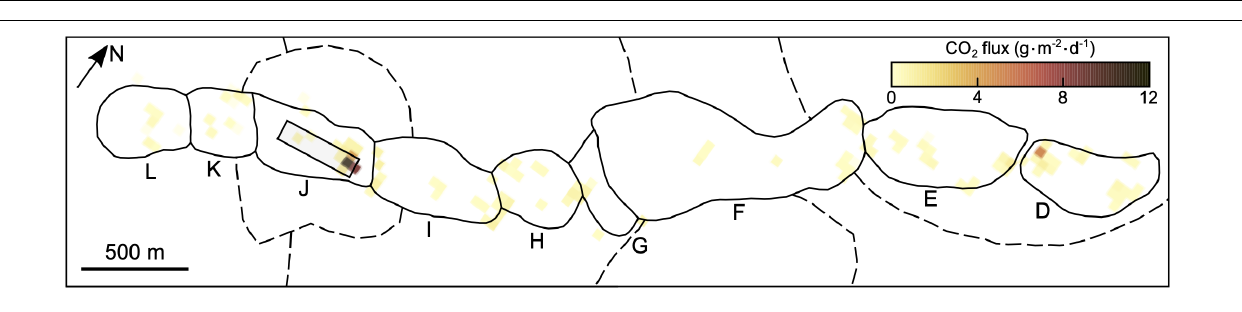
Frontiers in Earth Science |